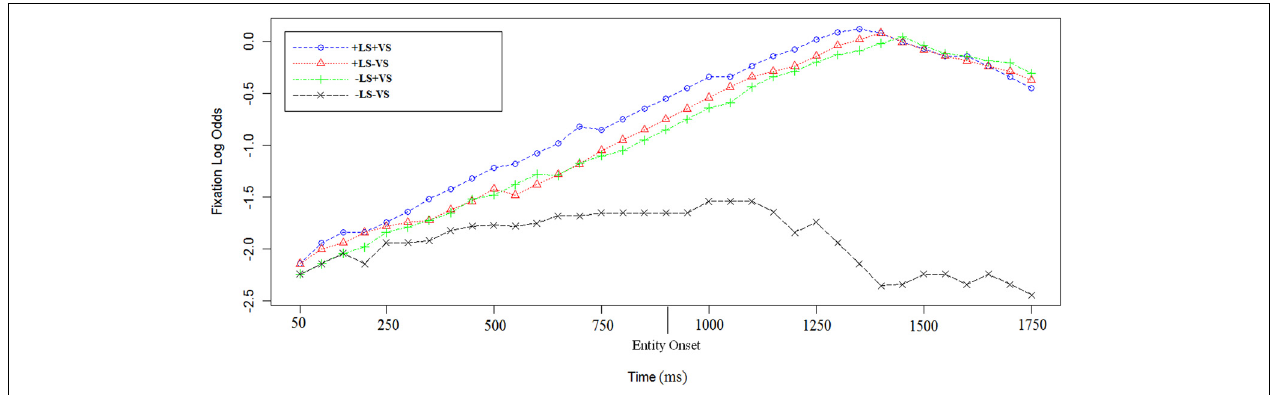
FIGURE 6 | Log odds of fixations during the last sentence in the four experimental conditions. In + LS conditions, participants had heard the linguistically salient entity (e.g., “Depero”) repeated for the fourth time. The